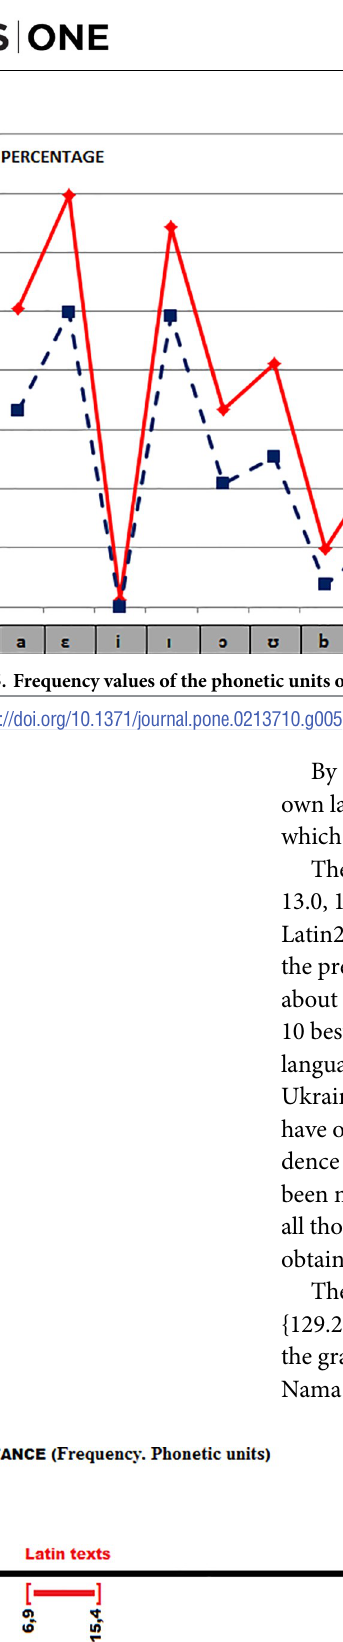
Fig 6. Distances between the Latin (average value) with all the texts of all the languages (phonetic units).